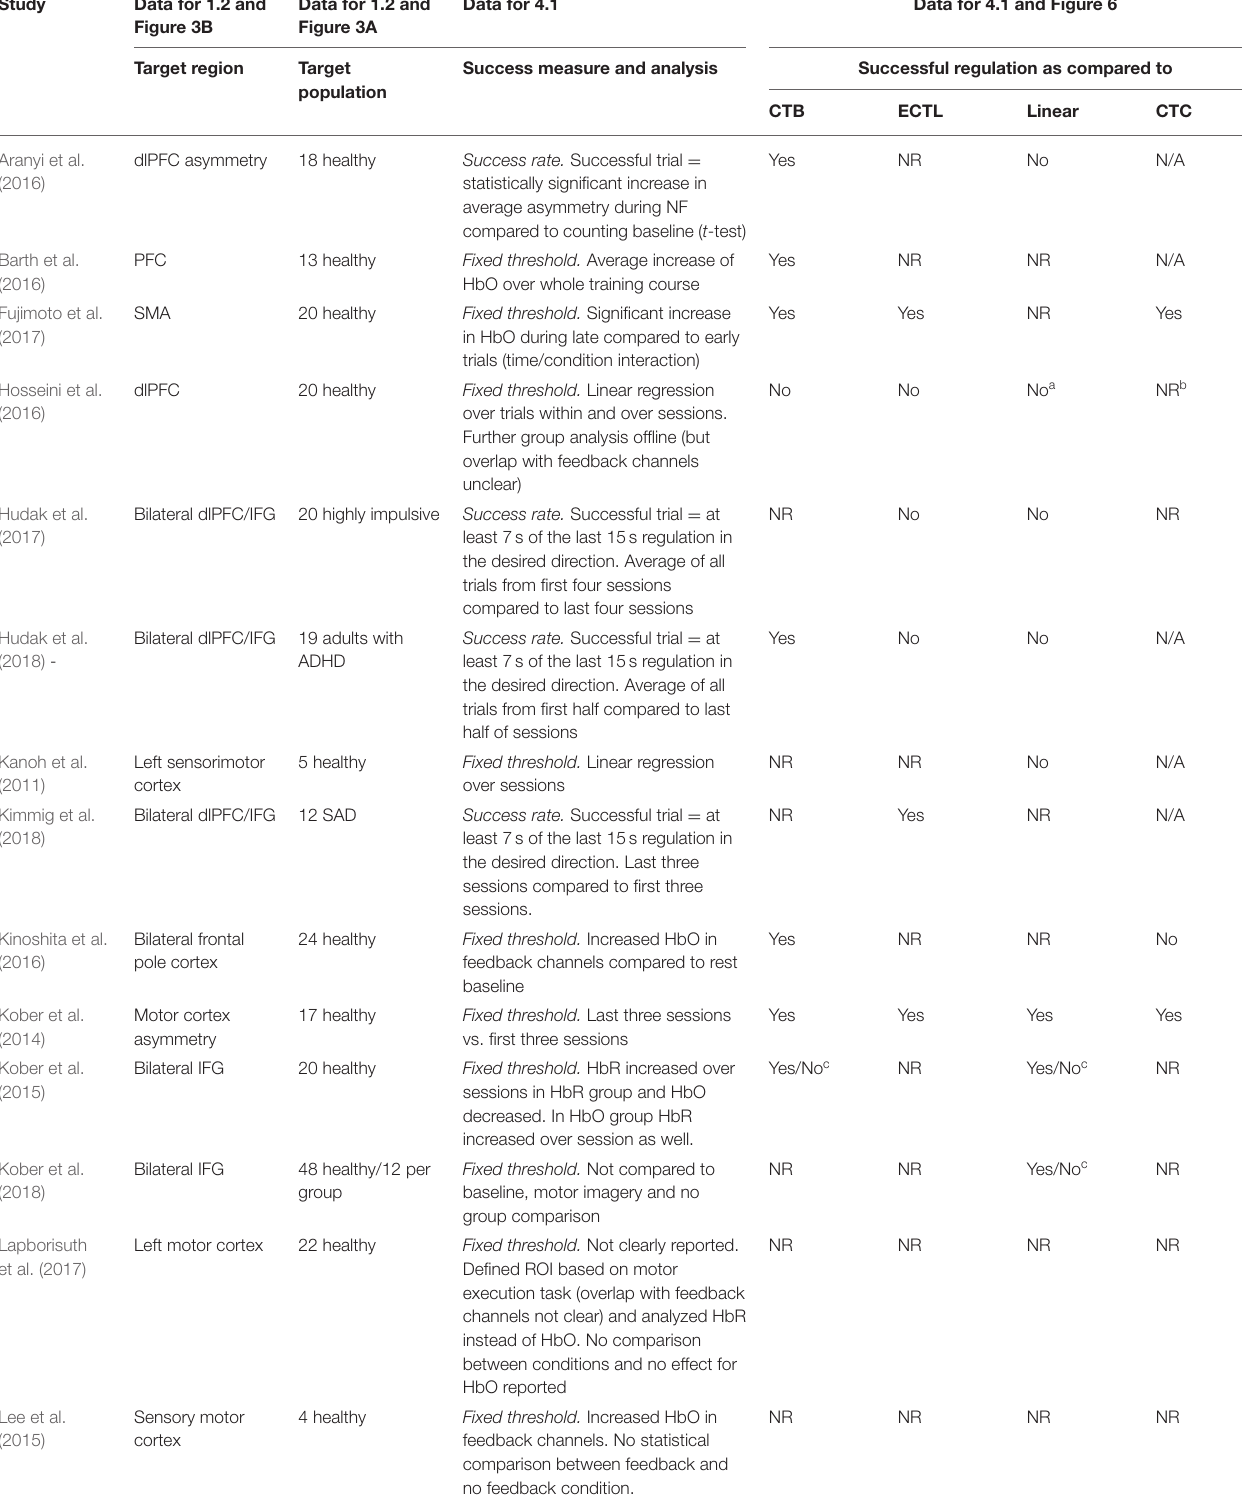
TABLE 6 | Neurofeedback regulation success.